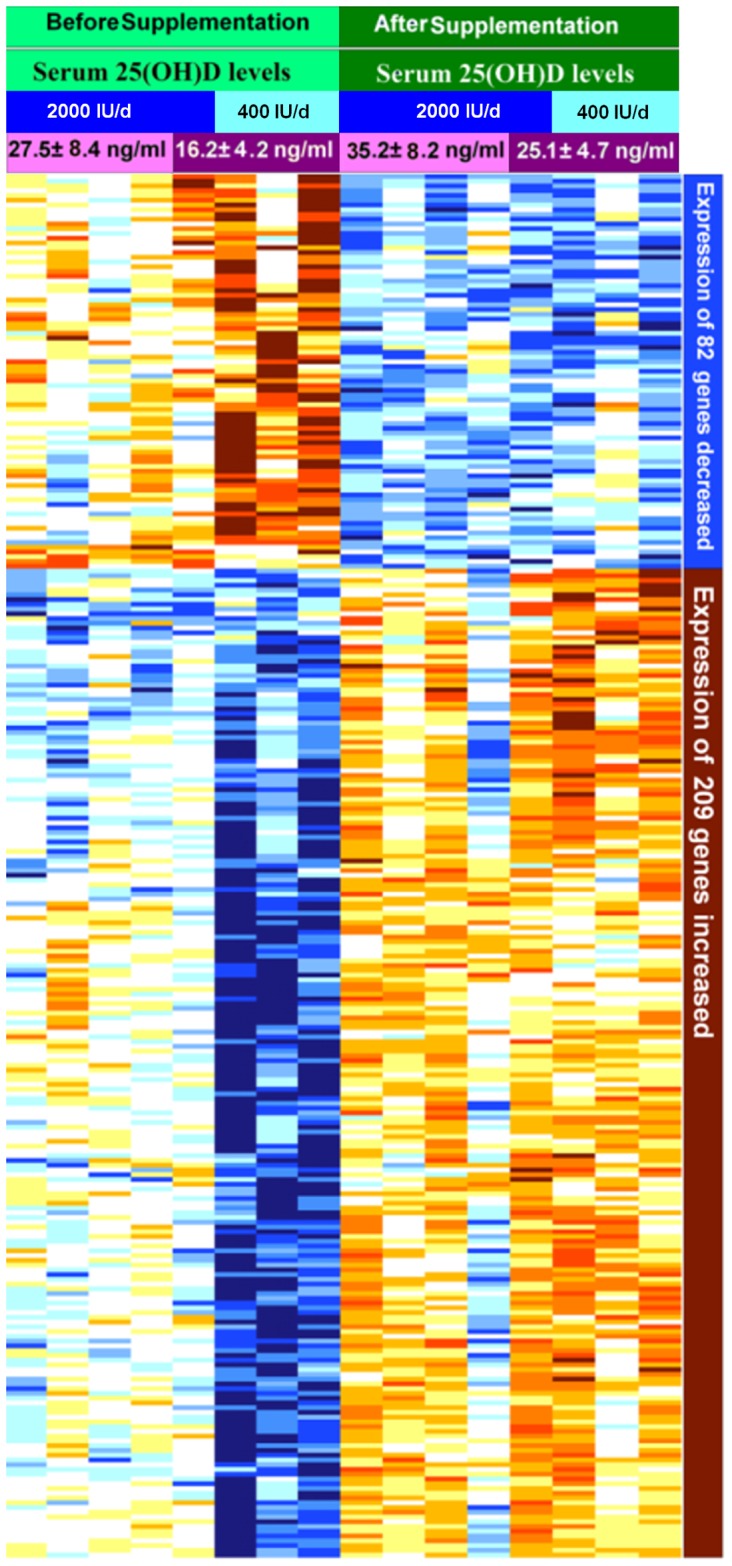
Heatmaps of vitamin D responsive genes whose expression levels change after 2 months vitamin D3 supplementation.Before supplementation (light green) four subjects were vitamin D deficient with 25(OH)D of 16.2±4.2 ng/ml (dark purple) and the other four subjects were insufficient or sufficient with a 25(OH)D of 27.5±8.4 ng/ml(light purple). After supplementation (dark green) serum levels of 25(OH)D in vitamin D insufficient/sufficient subjects increased to 35.2±8.2 ng/ml (light purple) and in the vitamin deficient subjects increased to 25.1± 4.7 ng/ml(dark purple). Two groups of gene-expression changes are seen based on stimulation (brown) or inhibition (blue) of gene expression post vitamin D3 supplementation. (Colors ranged from blue to brown; High expression  =  brown, average expression  =  white, low expression  =  blue). Clustering of the 291 genes affected by vitamin D3 supplementation was based on stimulation (brown) or inhibition (blue) of gene expression. The list of the 291 genes is shown in Table S1.